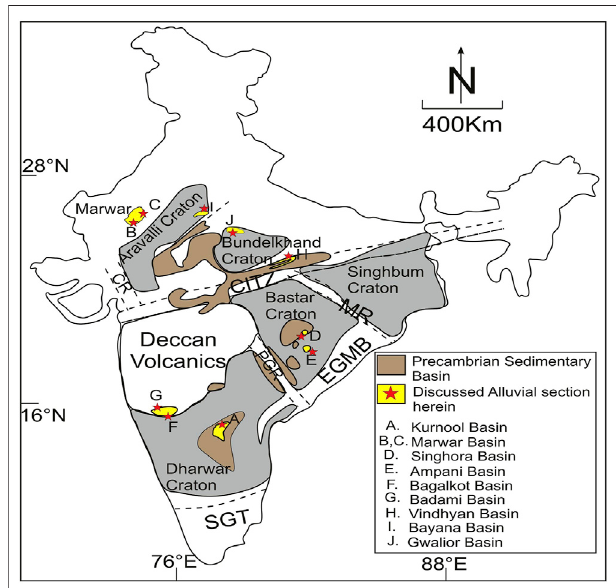
FIGURE 1 | Indian peninsula, cratons therein, and Precambrian sedimentary basins. Location of discussed alluvial sections marked by